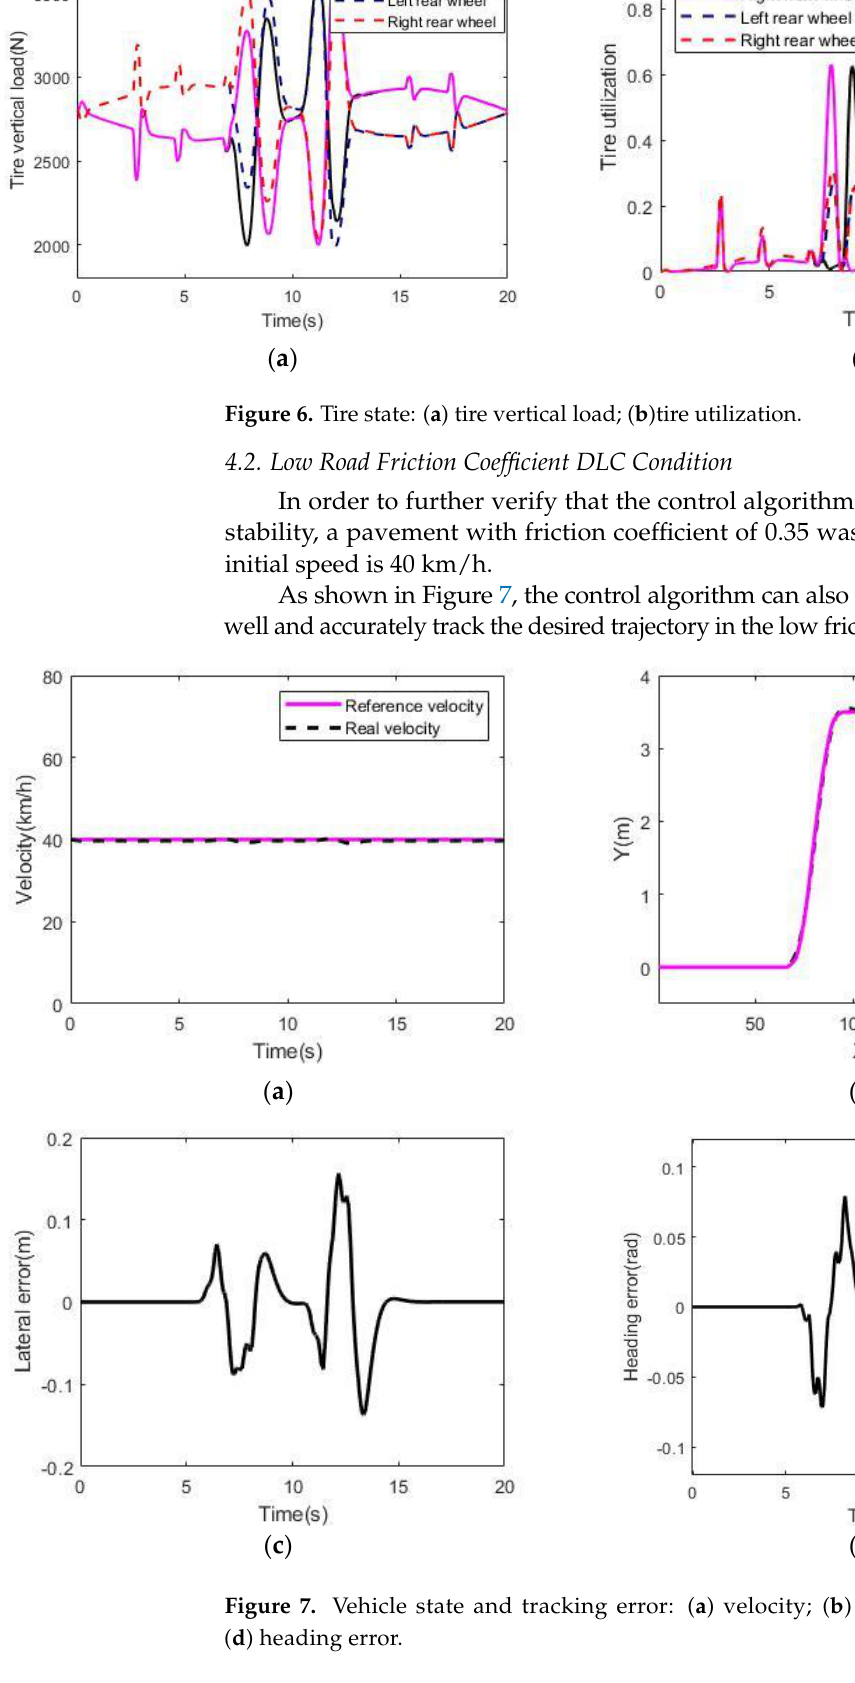
Figure 6. Tire state: ( a ) tire vertical load; ( b )tire utilization.